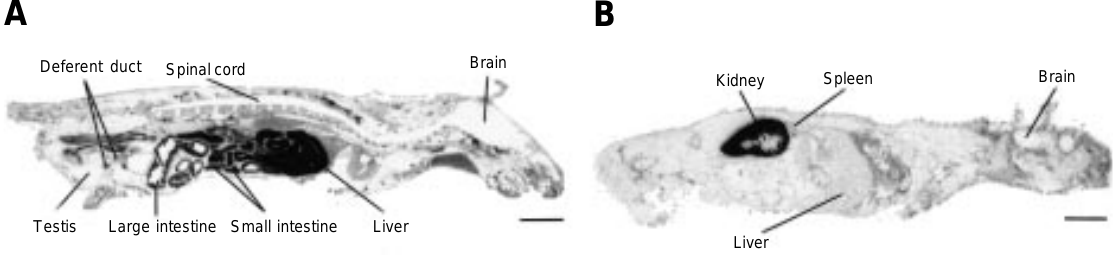
Testis LiverLarge intestine Small intestine Figure 1 - Whole body radioautographs showing the distribution of total (A) and nonspecific (B) insulin-binding sites in mice 3 min after 125 I-insulin injection. The mice were injected intravenously with 185 kBq of 125 I-insulin (porcine, 125 I-Tyr A14 insulin dissolved in Ringer solution at a concentration of 185 kBq/0.4 ml) in the absence (A) or presence (B) of excess (50 µg) unlabeled insulin. Bar = 1 cm.